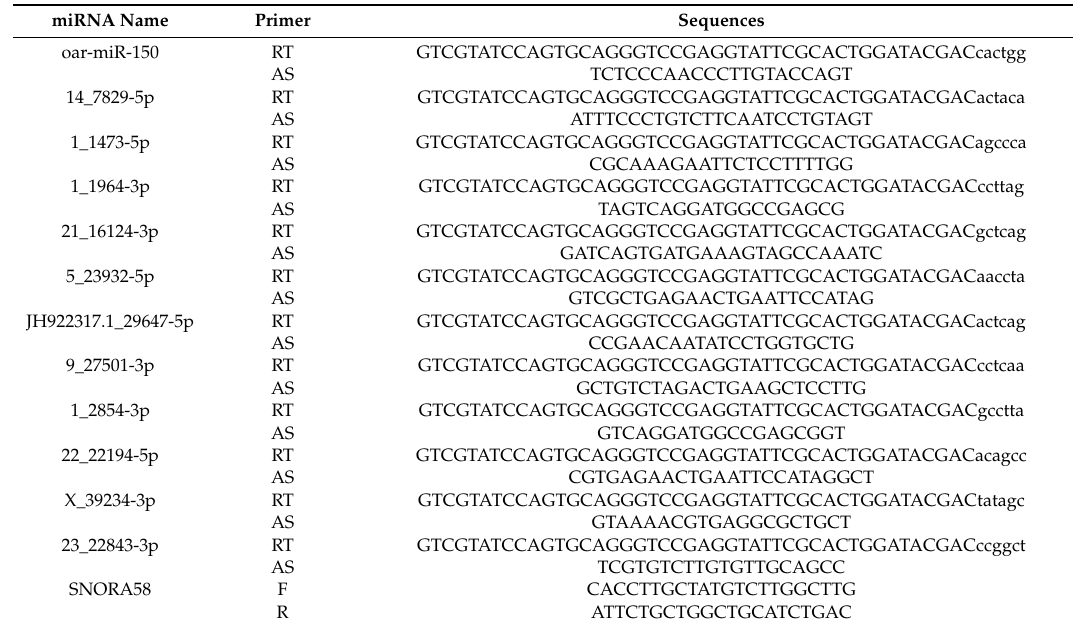
Table 1. Primers used for detection of microRNA (miRNA) expression using stem-loop real-time quantitative PCR